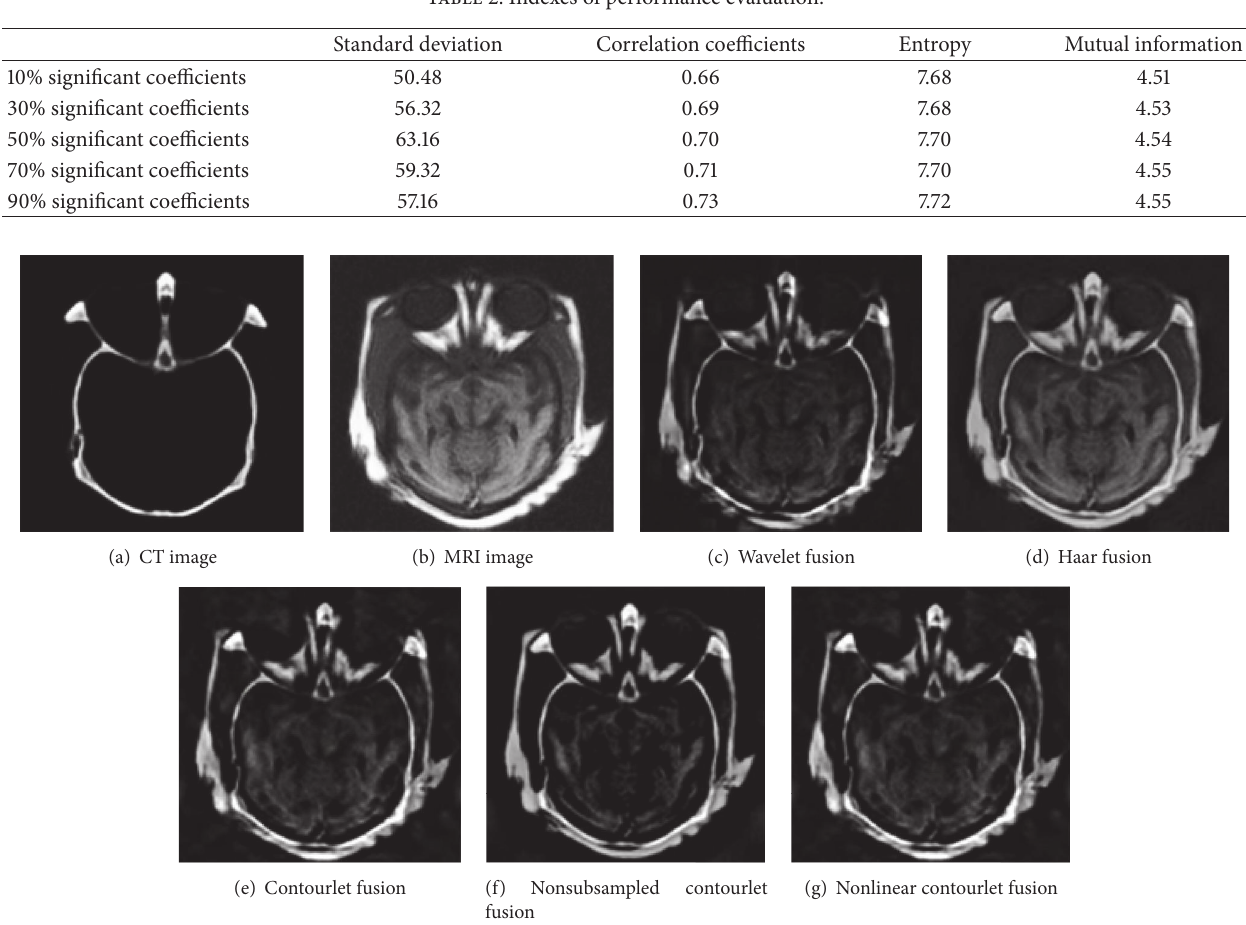
Figure 3: Fusion results’